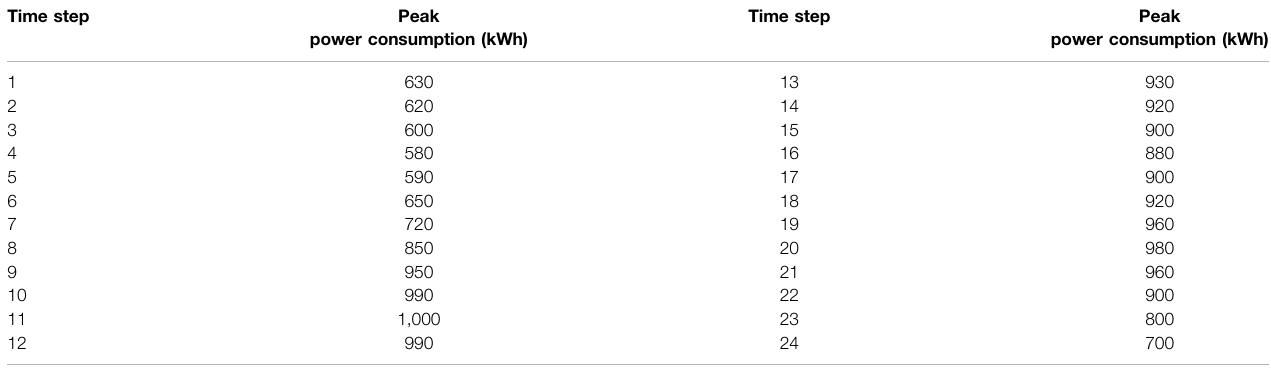
TABLE 6 | Peak of power consumption of the studied distribution system per